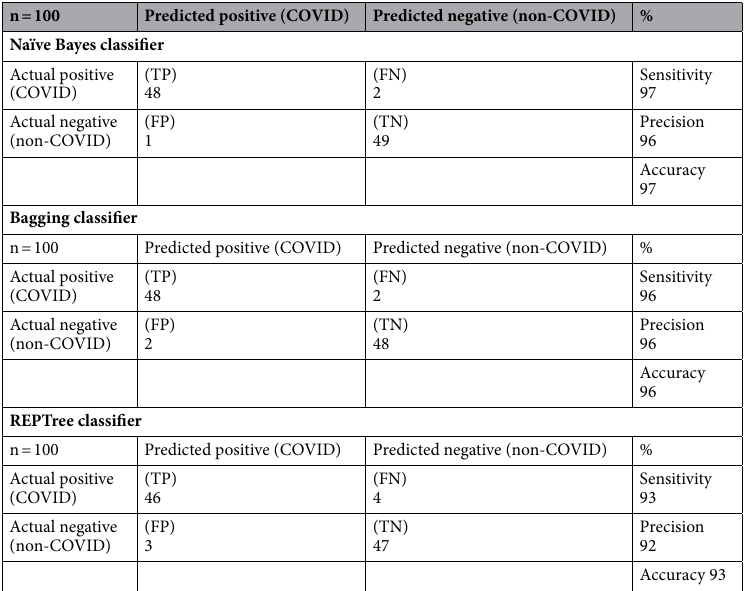
Table 2. Confusion Matrix for Naïve Bayes, Bagging and REPTree. TP Number of COVID images correctly classified as COVID, FP Number of non-COVID images incorrectly classified as COVID, TN Number of